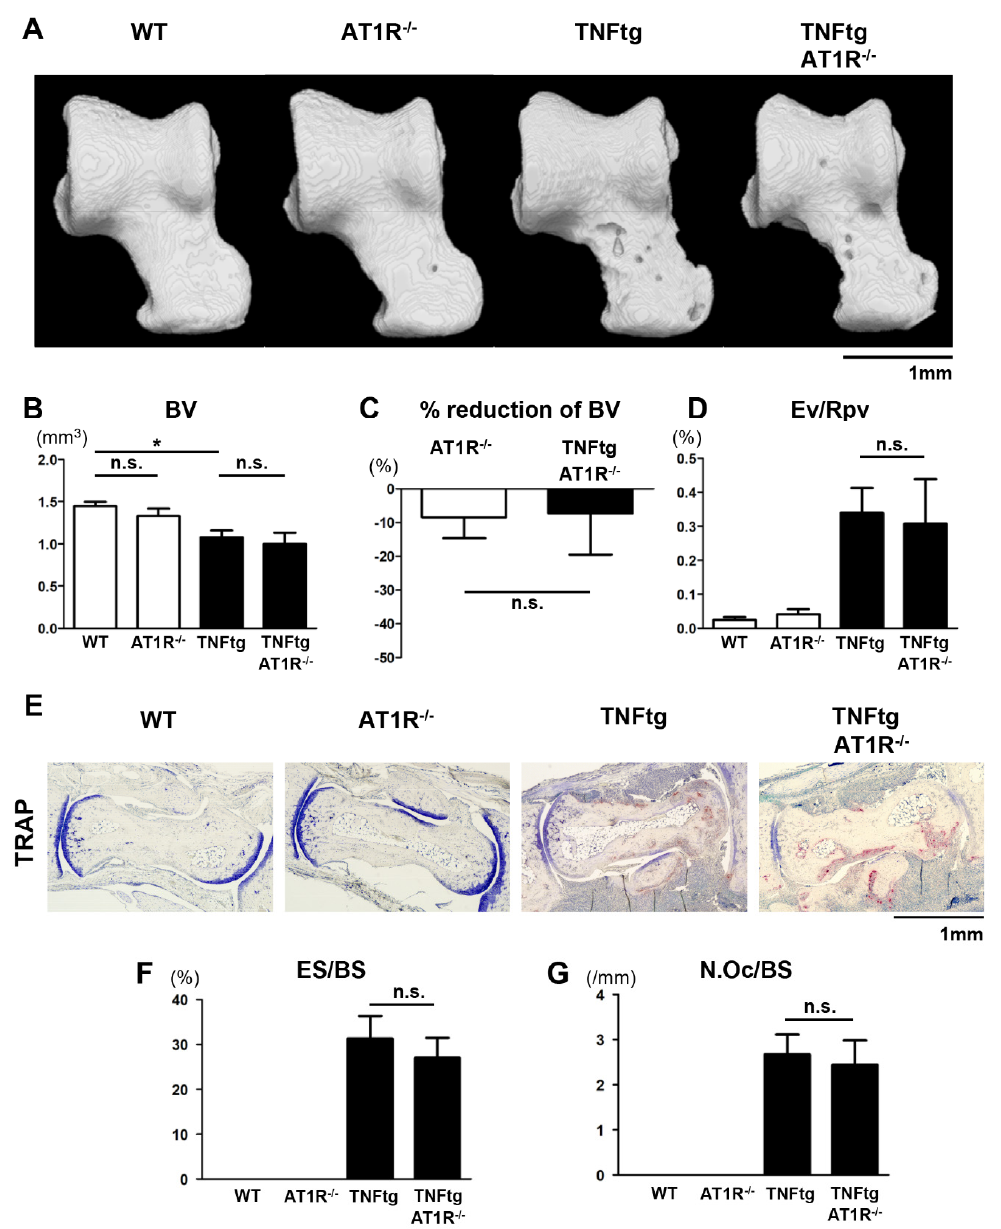
Figure 5. Influence of AT1R depletion on bone erosion in tumor necrosis factor-transgenic (TNFtg) mice. TNFtg mice were crossed with AT1R-deficient (AT1R − / − ) mice. WT ( n = 9), AT1R − / − ( n = 7), TNFtg ( n = 12), and TNFtg AT1R − / − ( n = 8) male mice were analyzed at the age of 16 weeks. ( A ) Representative 3D micro-CT images of the talus. ( B ) Bone volume (BV) of the talus. ( C ) Rate of reduction in BV by AT1R deficiency relative to that in the control mice of each genotype. ( D ) Eroded volume per repaired volume (Ev/Rpv) of the talus. ( E ) Representative images of tartrate-resistant acid phosphatase (TRAP) staining around the talus bones of indicated mice; original magnification ×40. ( F ) Eroded surface per bone surface (ES/BS) around the taluses. ( G ) The number of osteoclasts per bone surface (N.Oc/BS) around the taluses. Values are the mean ± SEM. n.s., not significant. *, p < 0.05.